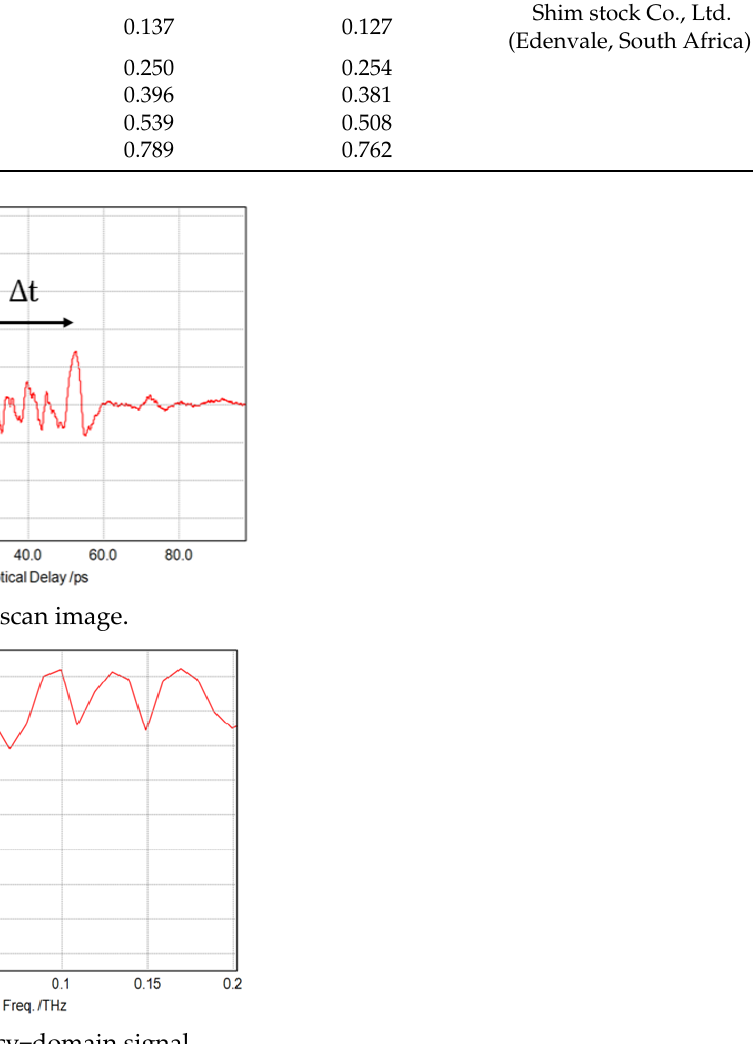
Table 2. Measurements of the Shim stock films with various thicknesses using the THz techniques. Sample No.